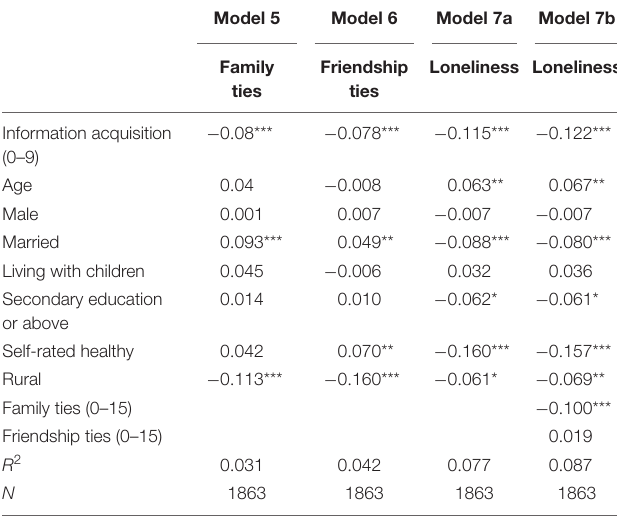
TABLE 4 | Social networks and loneliness regressed on information acquisition ( β ).